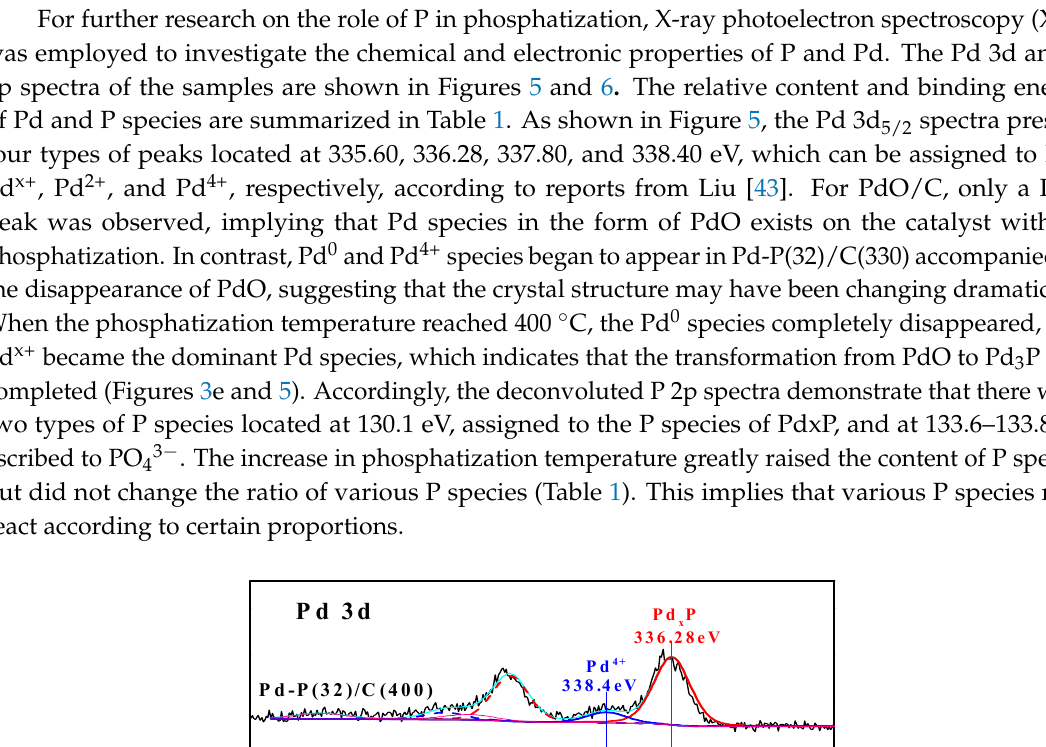
Figure 4. The relationship diagram of the average sizes of Pd particles of Pd-P/C catalysts and n(P)/n(Pd).